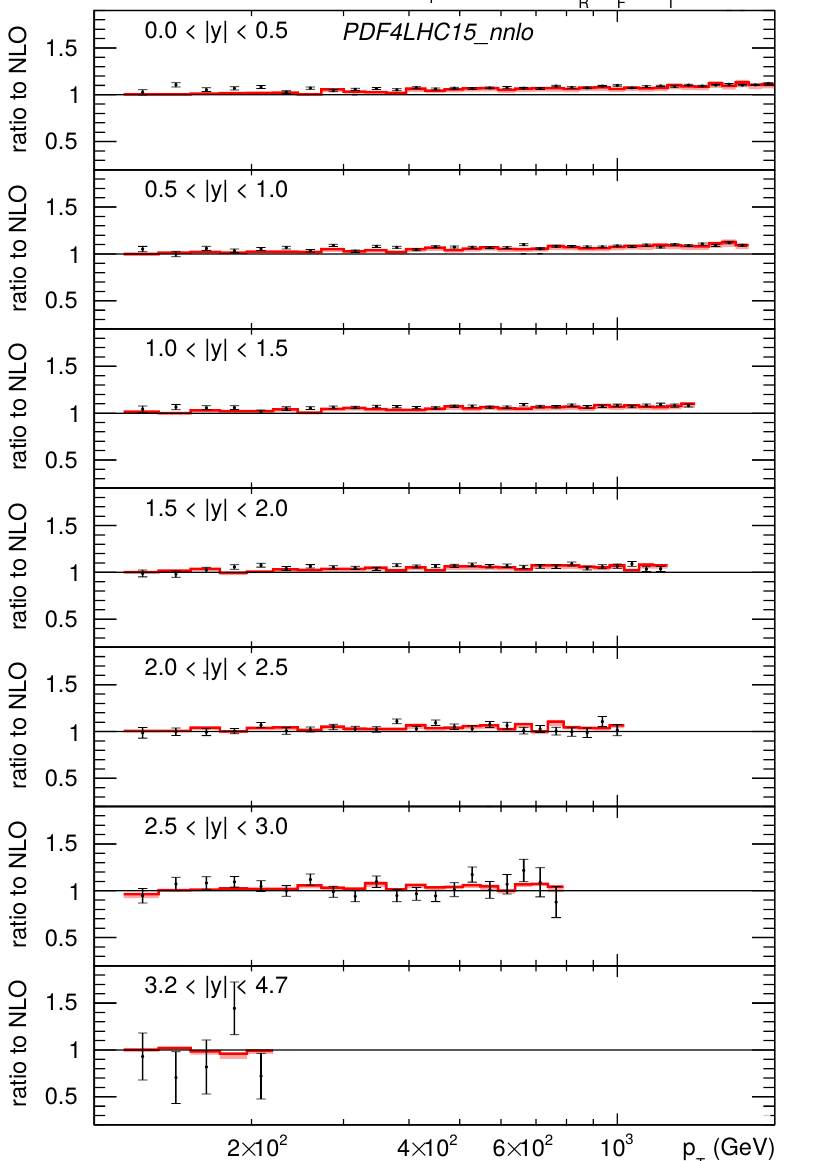
Figure 3 . Comparison of the cross section ratios depicted in (cid:12)gure 2 as obtained with NNLO- jet [23] (red line with scale variation error, leading-color approximation for channels involving quarks) and with Stripper (black points with Monte Carlo integration error bars, as given in appendix D, exact in color). This (cid:12)gure has been obtained from (cid:12)gure 21 of [23] by removing the experimental data points as well as the scale variation band of the NLO calculation, followed by superimposing the results obtained in the present